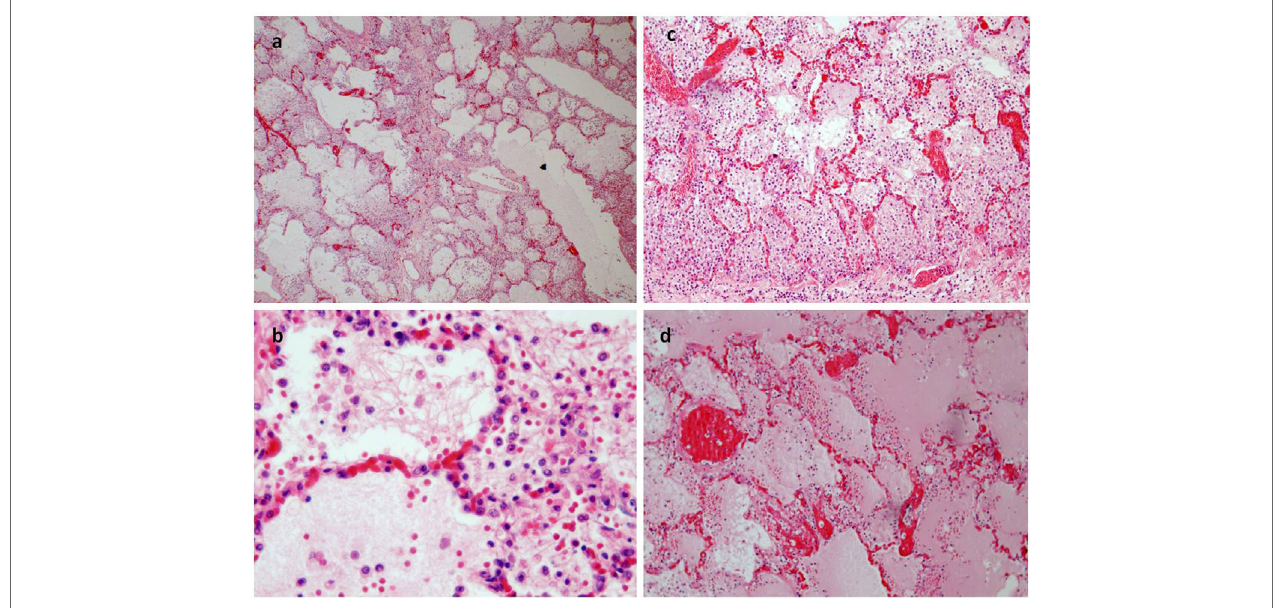
FIgURe 3 | (a) Pulmonary emphysema (E/E 20 × ). (B–D) The alveoli were filled an effusion rich in protein and a rich infiltrate of eosinophil granulocytes too [E/E 63 × in (B) ; 40 × in (C) ]. (D) The congestion of pulmonary vessels and proteinaceus aedema (E/E 40 ×